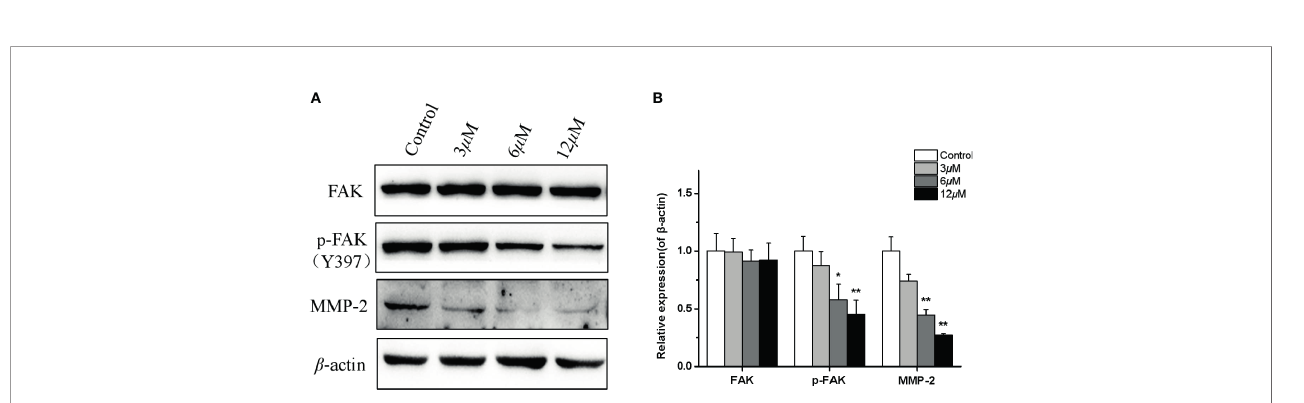
FIGURE 5 | Effects of casearlucin A on apoptosis related proteins expression in HepG2 cells. HepG2 cells were pre-treated with casearlucin A for 36 h, and western blotting analysis was performed. DMSO was used as a negative control. (A) Western blotting results of protein levels. (B) Quantitative analysis of apoptosis related proteins expression. b -Actin protein was used as internal reference. ** p < 0.01 compared with control group cells. Data were obtained by at least three independent experiments.